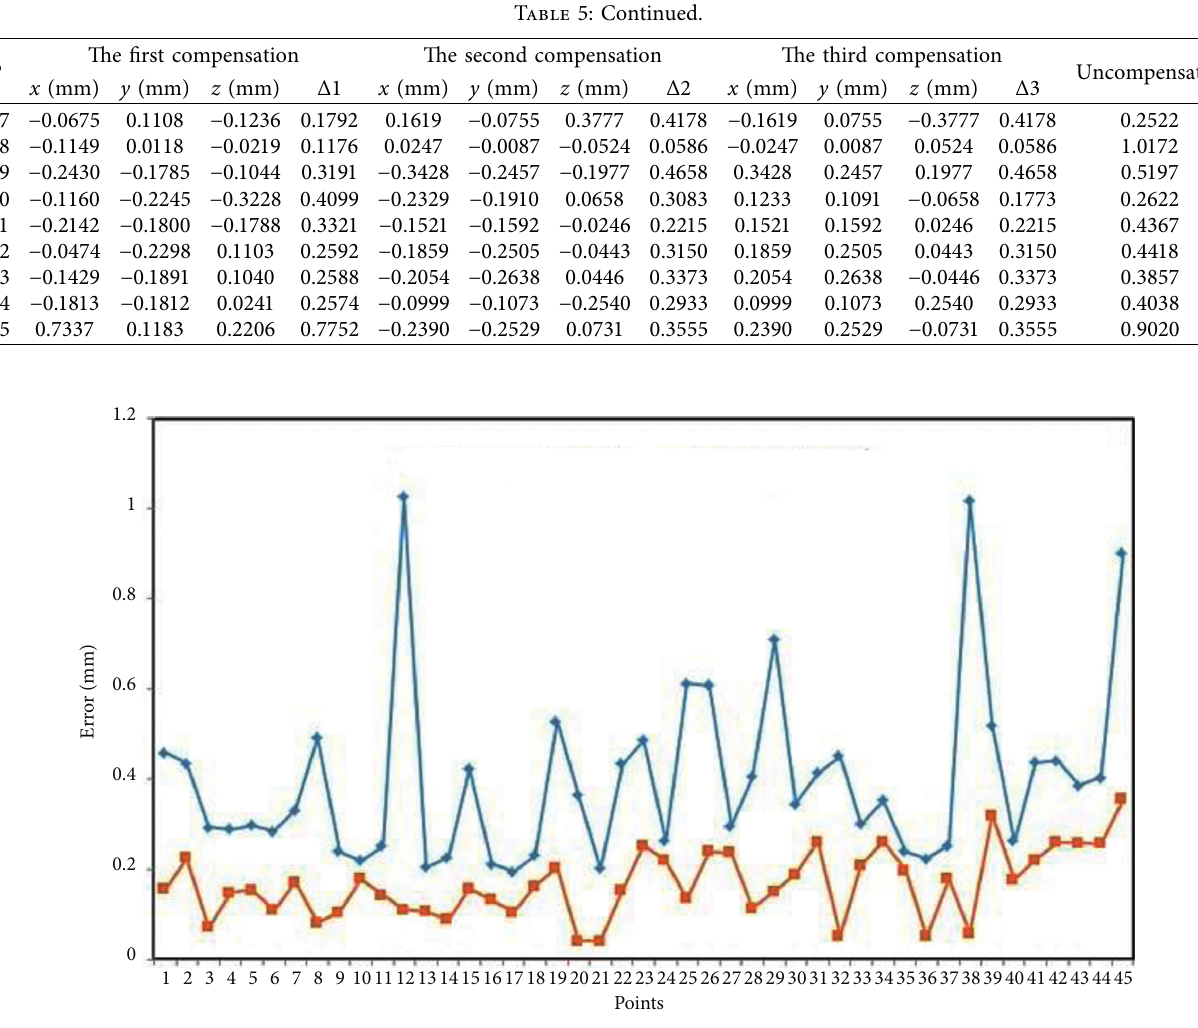
Figure 5: Graph of position error after changing the trajectory three times. The green line denotes the set of points when the trajectory is unchanged. The orange line denotes the set of points with the best error after changing the trajectory three